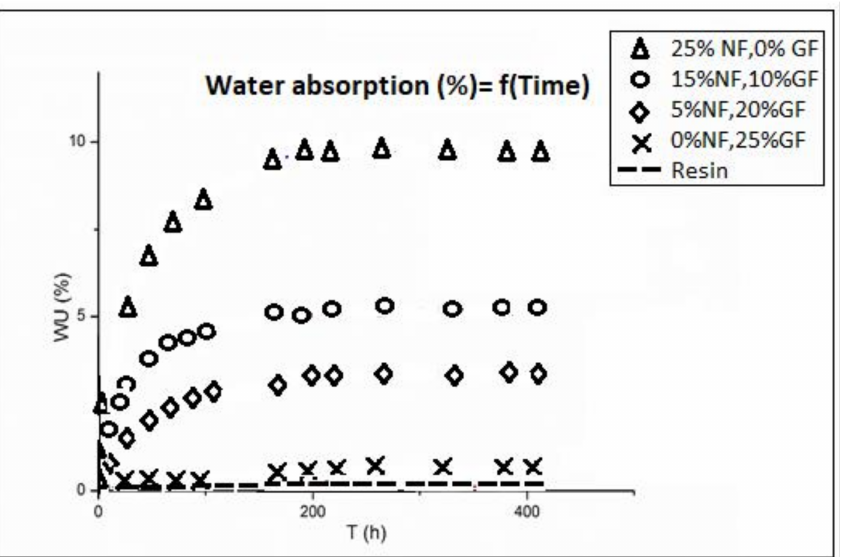
Figure 5. Water absorption vs.